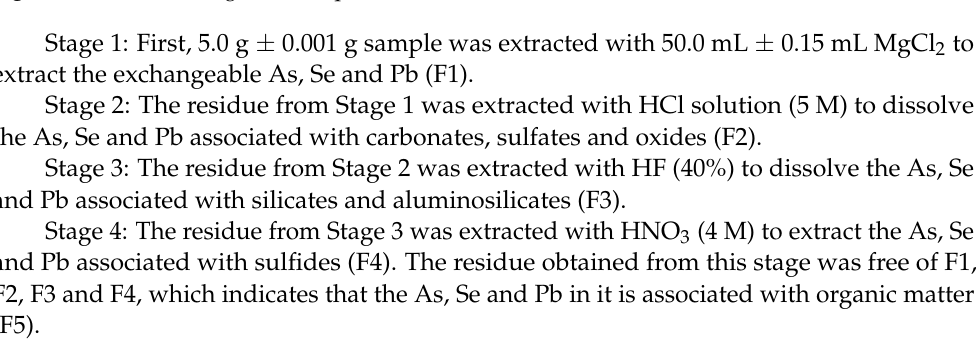
Figure 1. Schematic diagram of sequential chemical extraction